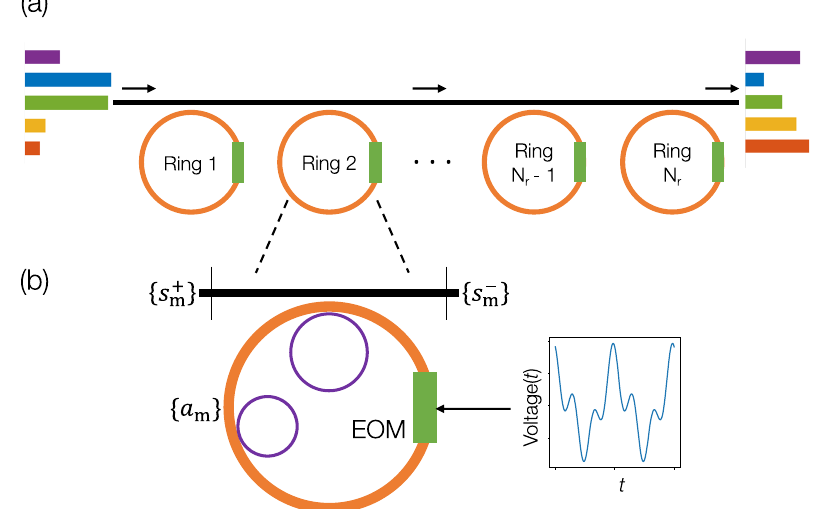
Fig. 1 Setup to implement arbitrary linear transformations in frequency space. a An array of dynamically modulated rings (orange) coupled to an external waveguide. The green blocks represent electro-optic modulators (EOMs) and the black line is an external waveguide coupling to each of the rings. The output spectrum on the right is the result of the transformation implemented by the system on the input spectrum (left). b Detailed view of a single ring depicting the waveguide port inputs and outputs s ± m . The smaller purple circles indicate auxiliary rings that couple selectively to modes a m of the larger orange ring to implement frequency-dimension truncation to the ring spectrum. The time-periodic voltage pro fi le applied to the EOM is a result of the inverse-design